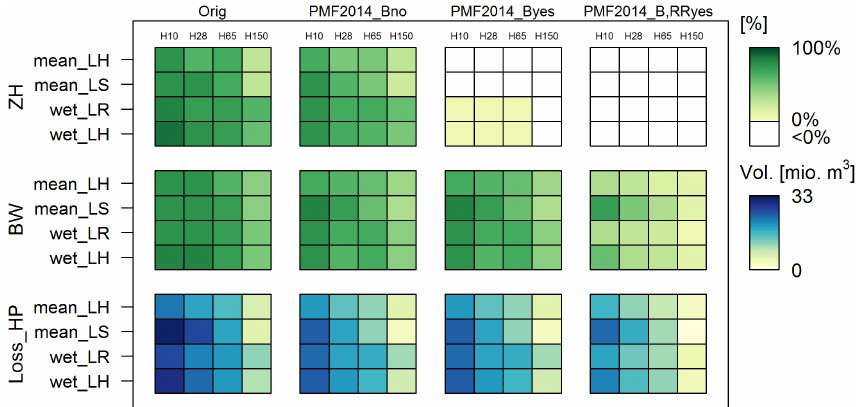
Figure 6. Effect of combined management procedures for selected combinations of initial conditions. Main rows: visualization of percentage of scenarios (Table 1) exceeding the peak of 350m 3 s − 1 at the Sihl gauge in Zürich (ZH), and the peak of 300m 3 s − 1 in Blattwag (BW). More details on the used notations in Sect. 4.3 and in Fig.